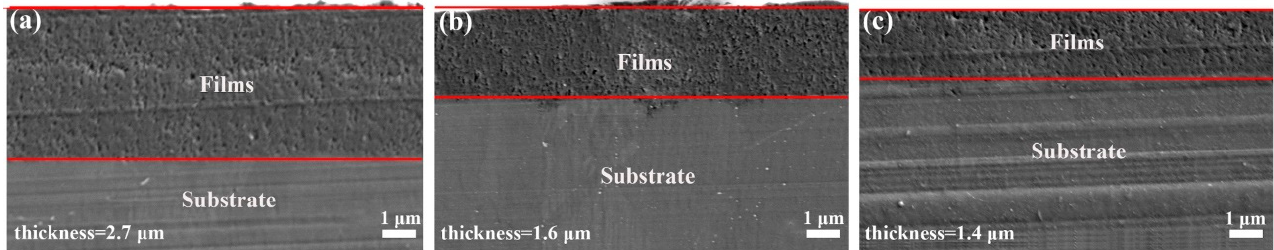
Figure 4. Cross-sectional morphology of the ( a ) ZM20-LDHs, ( b ) ZM21-LDHs, and ( c ) ZM22-LDHs films.